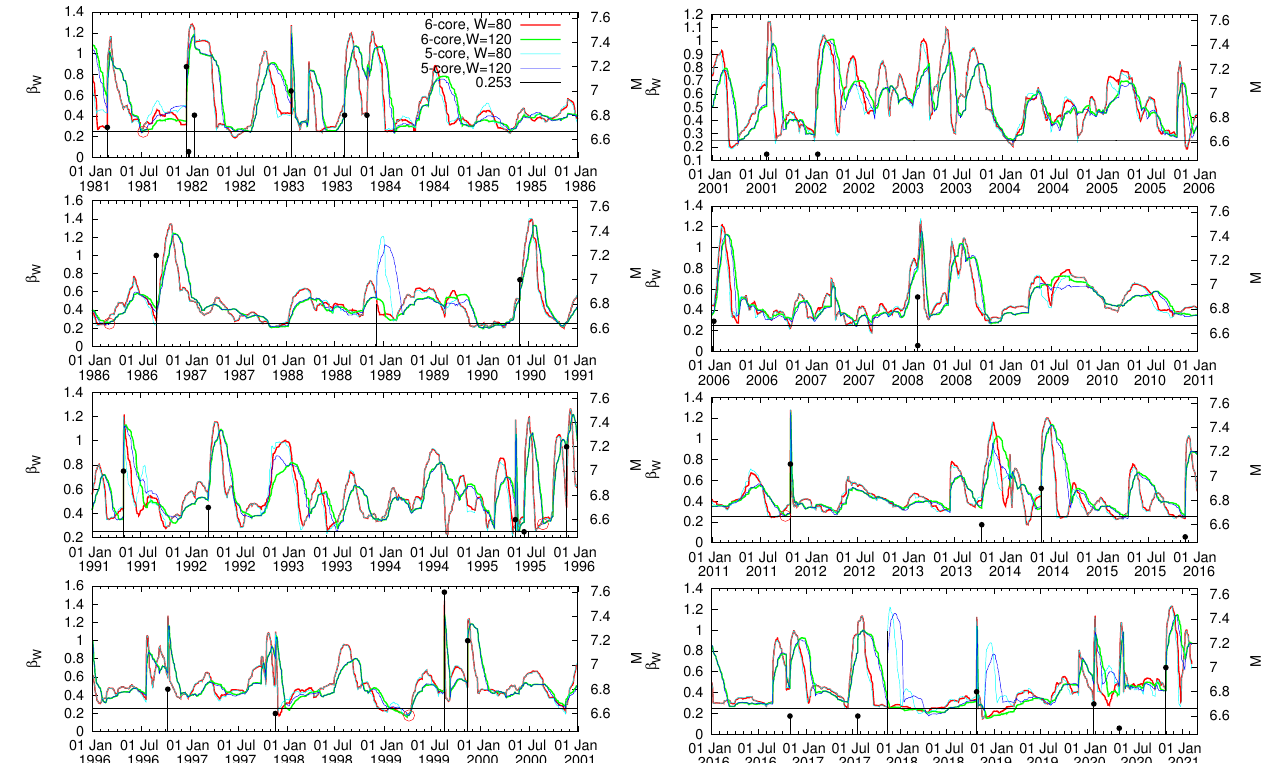
Figure 2. Results for the variabilities β W when W = 80 and 120 consecutive EQs of the seismicity order parameter κ 1 in natural time for the almost 40-year study period within the marginal geographical areas A 6 and A 5 that enclose the 6-core and the 5-core of the ENBOSAP of the region N 50 E 46 , respectively. The magnitude of EQs (right scale) is depicted by the 25 5 (black) vertical lines ending in solid circles for EQs that occur within the A 6 . When the vertical line does not end in a solid circle, the EQ occurs inside the A 5 , but outside the A 6 , i.e, the 2017 M7.3 Halabja EQ. The (red) open circles indicate the uniquely identified minima β 120 [115] when comparing the β W values for both areas A 6 and A 5 . They precede all the mainshocks of M ≥ 7.1 within A 6 by six months at the most, without false alarms, see the red rectangle of Figure 1. The horizontal line at 0.253 was designed as an eye